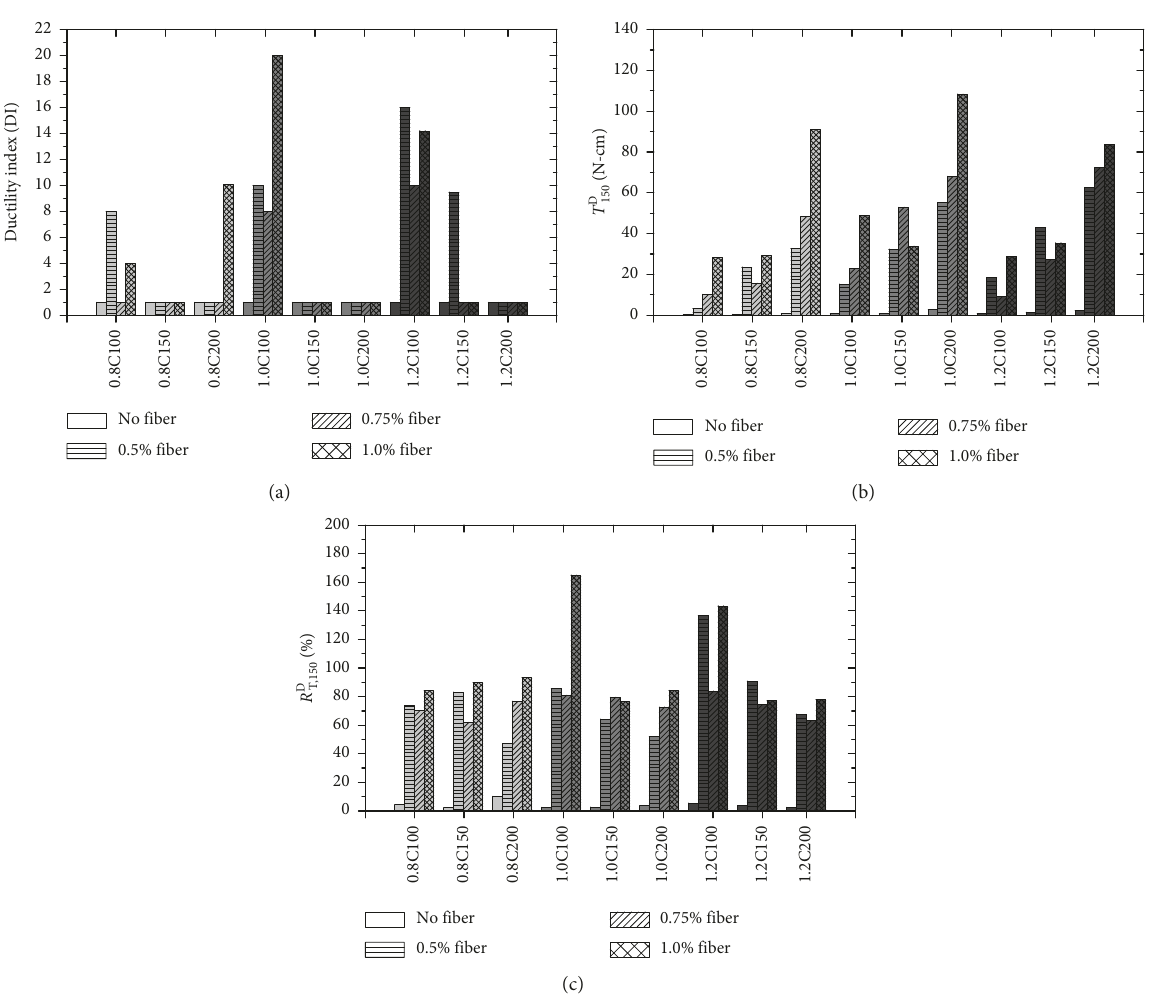
, and (c) R D 150 T , 150